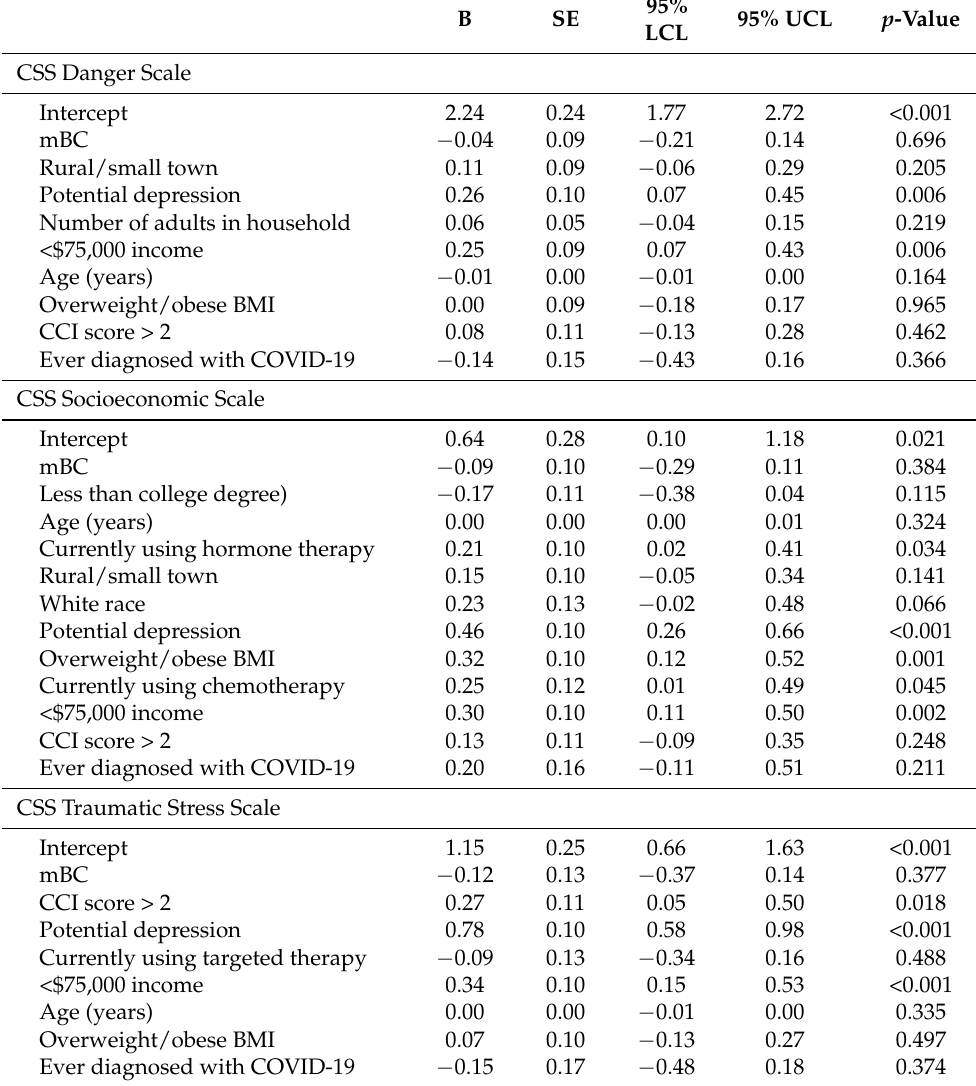
Table 3. Factors Associated with COVID-Related Stress: Generalized Linear